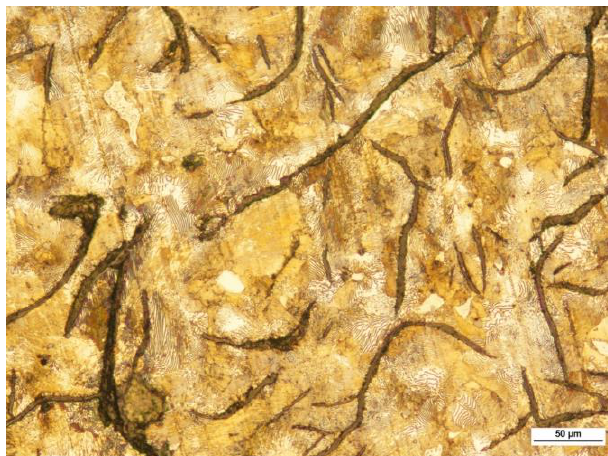
Fig. 8. Microstructure of the analyzed brake disc; visible flakes of graphite on the background of perlite matrix; precipitations of phosphite eutectic and manganese sulfides are also observed locally; light microscopy, etched with HNO 3 Phosphite eutectic precipitations are visible in Fig. 9.